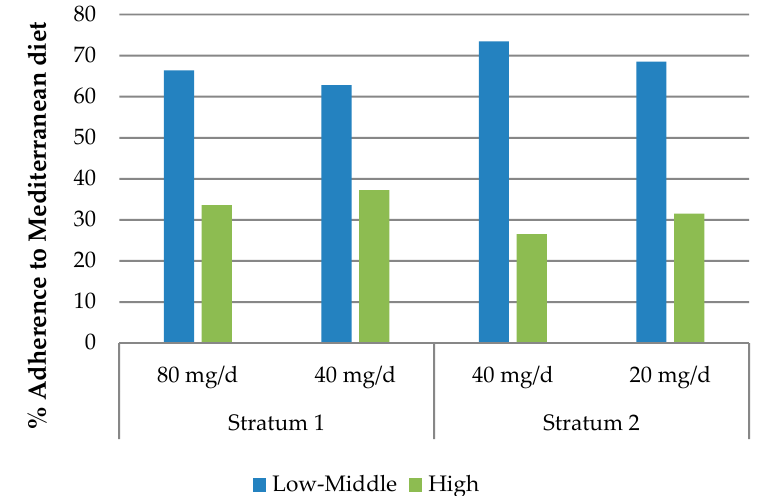
Figure 1. Flowchart of the study. Nutrients 2019 , 11 , x FOR PEER REVIEW